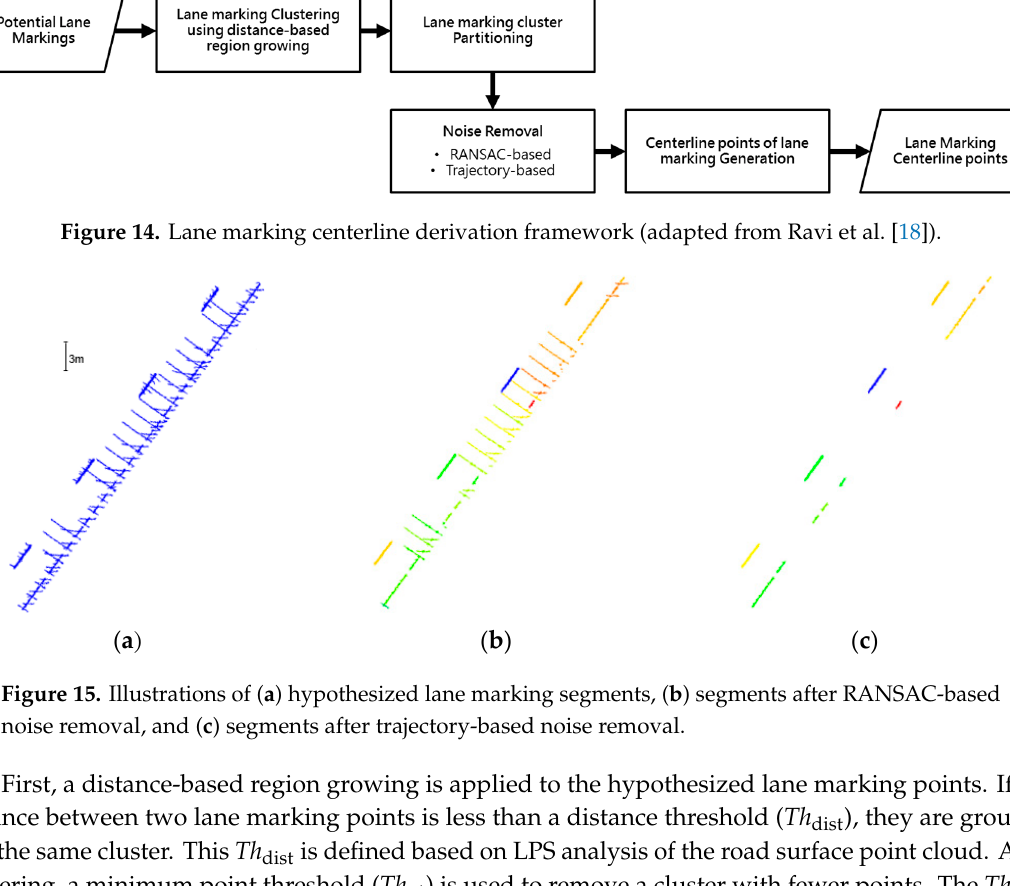
( c ) Figure 13. U-net prediction refinement: ( a ) mask regions formed by 5-cm cells, ( b ) two-dimensional (2D) masks overlaid on points whose intensity is in the 5th percentile intensity of the original point cloud, and ( c ) predicted lane markings. 4.2. Lane Width Estimation Approach To evaluate the performance of various lane marking extraction strategies, the lane width estimation approach proposed by Ravi et al. [18] is used after its adaptation to handle derived lane markings from intensity thresholding and deep learning strategies. Since predicted markings using